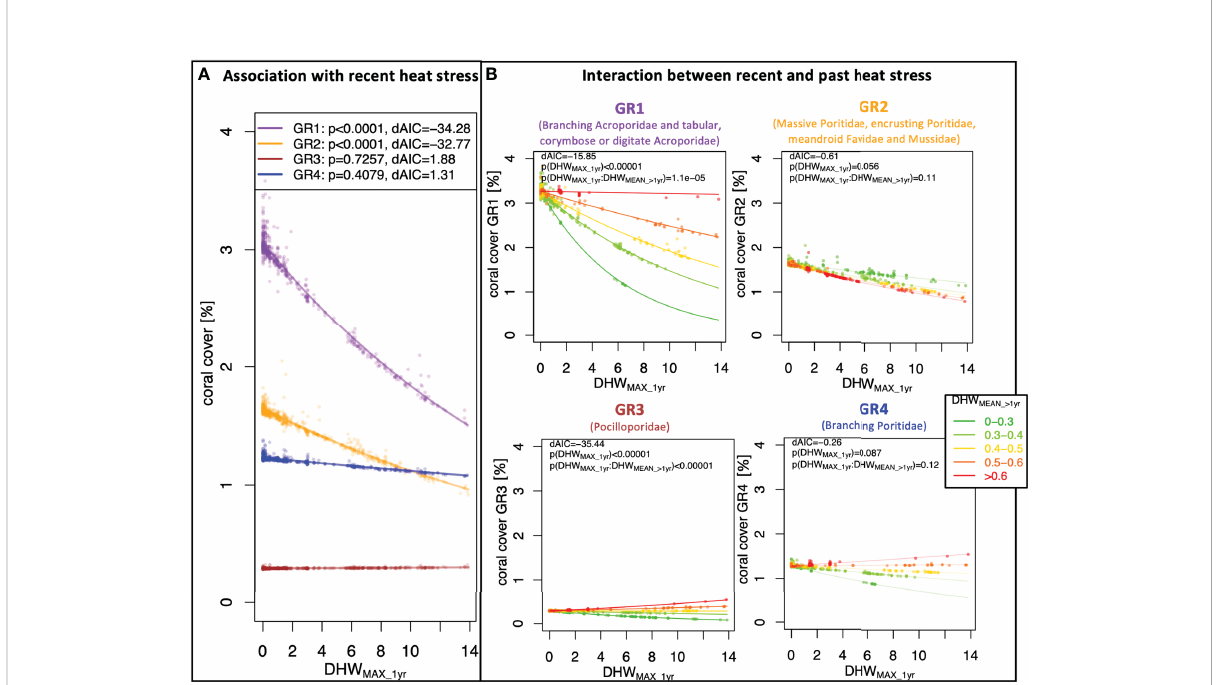
FIGURE 3 Groups of coral cover-heat stress associations. The plots display the associations between local coral cover and heat stress trends at survey sites for the four groupings of taxa with similar heat responses (heat association groups): in Group 1 (GR1, purple), taxa coral cover is associated with recent heat stress, where this association interacts with past heat stress; in Group 2 (GR2, orange), coral cover is associated with recent heat stress, without signi fi cant interaction with past heat stress; in Group 3 (GR3, brown), recent heat stress alone is not signi fi cantly associated with taxa coral cover, but the interaction between recent and past heat stress shows a signi fi cant association with coral cover; and in Group 4 (GR4, blue), no signi fi cant association between coral cover and heat stress was found. Plot (A) displays the association of coral cover with recent heat stress, measured as the maximal degree heating week measured during the year before the survey ( DHW MAX _1 yr ), for each of the four groups. Plots in (B) show the association of coral cover with recent heat stress, for survey locations exposed to different levels of past heat stress, measured as the average DHW during all the previous years ( DHW MEAN _>1 yr ). For each association model, the plots display the goodness- of- fi t compared to a null model ( dAIC ) along with the p-values (p) of the fi xed